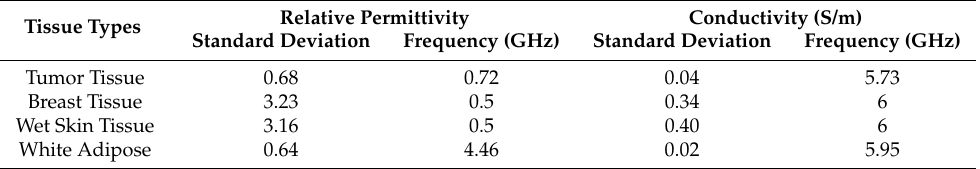
Figure 3. Median dielectric property measurement results between 0.5 and 6 GHz collected from various rat tissues including tumor, breast, skin, white adipose tissues: ( a ) relative permittivity and ( b ) conductivity. Table 1. Maximum standard deviation from the mean of five measurements for rat tissues (tumor, breast, wet skin and white adipose) over the frequency range of 0.5–6